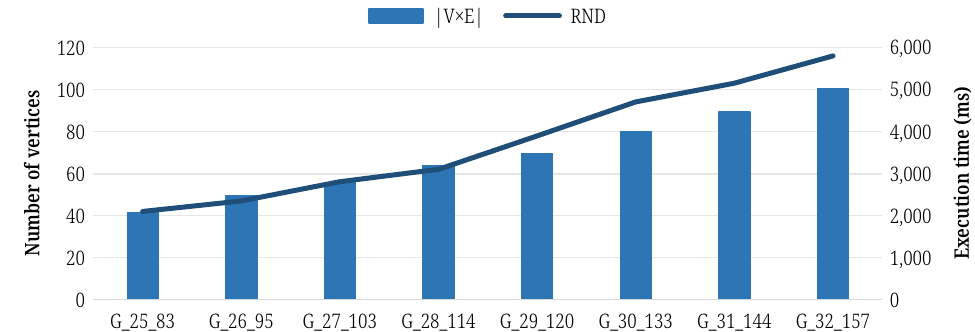
Fig. 10. Influence of the number of vertices and edges in the graph on the execution time of the algorithm with randomly generated vertex orders –